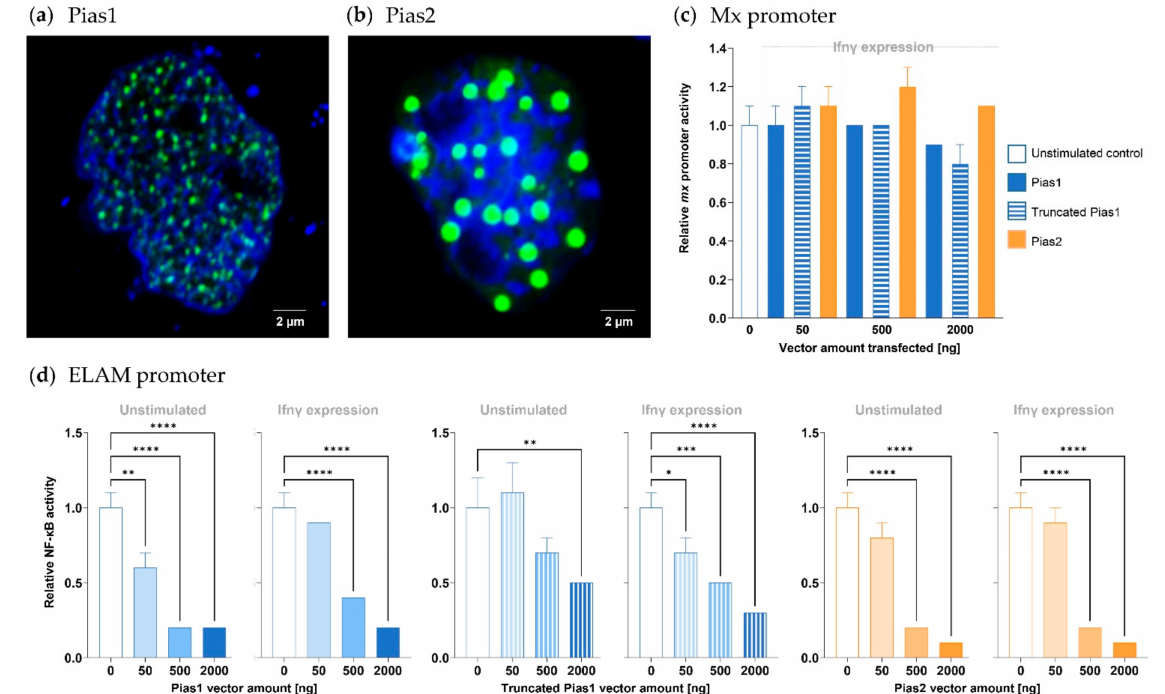
Figure 8. Overexpression of Pias factors in salmonid cell models. Confocal analysis of ( a ) GFP-tagged Pias1 (green) and ( b ) GFP-tagged Pias2 (green) in CHSE-214 cells; nuclei were stained with Hoechst 33342 dye (blue). The white scale bar represents 2 µ m. The luciferase activity of CHSE-214 cells co-expressing ( c ) mx -reporter construct or ( d ) ELAM -reporter construct was determined in unstimulated control cells or ifn γ -expressing cells (as indicated above the graphs) co-expressing increasing concentrations of the pias -expressing vector (indicated on the abscissa). The luciferase activity in all cell cultures not expressing pias was set to 1.0. Statistical significance compared with the control group was assessed using one-way ANOVA (*, p < 0.05; **, p < 0.01; ***, p < 0.001; ****, p < 0.0001). The standard error of the mean (SEM) is